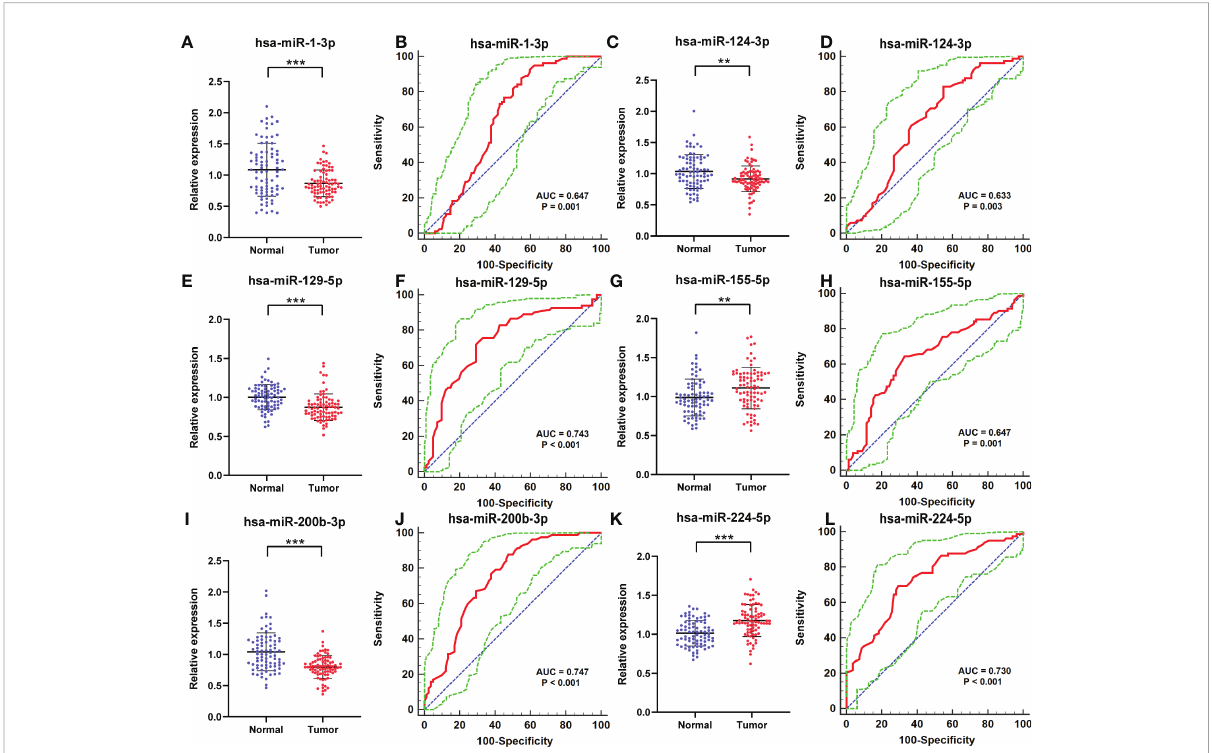
FIGURE 3 Relative expression counting and receiver operating characteristic curve (ROC) analyses in the validation phase of six elected miRNAs. This phase consisted of 82 RCCs and 82 NC serum samples. In RCC, the miRNAs with higher expression were miR-155-5p (G) and miR-224-5p (K) ; their AUCs are 0.647 (95% CI: 0.568 – 0.720; p= 0.001; (H) and 0.730 (95% CI: 0.655 – 0.796; p < 0.001; (L) . Signi fi cantly lower expressed miRNAs were as follows: miR-1-3p (A) , miR-124-3p (C) , miR-129-5p (E) , and miR-200b-3p (I) . Their AUCs are 0.647 (95% CI: 0.569 – 0.720; p =0.0001; (B) , 0.633 (95% CI: 0.554 – 0.706; p = 0.003; (D) , 0.743 (95% CI: 0.669 – 0.808; p< 0.001; (F) , and 0.747 (95% CI: 0.674 – 0.812; p< 0.001; (J) . **p < 0.01, ***p < 0.001.